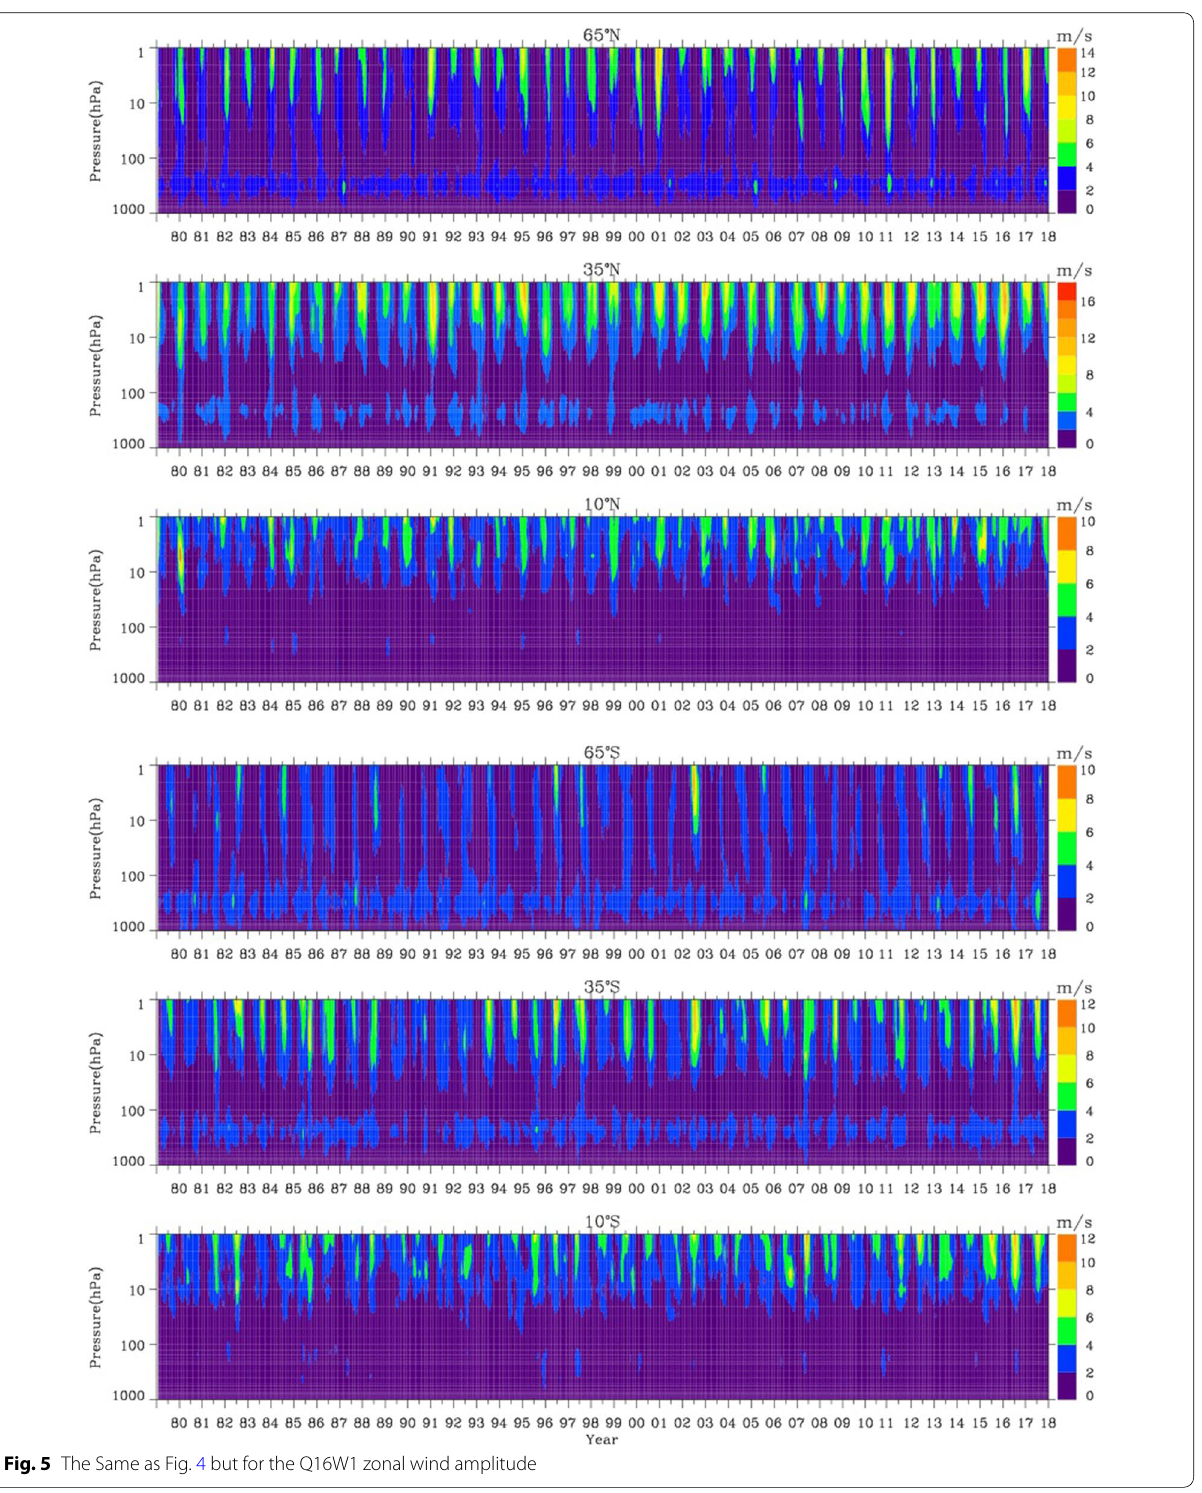
Fig. 5 The Same as Fig. 4 but for the Q16W1 zonal wind